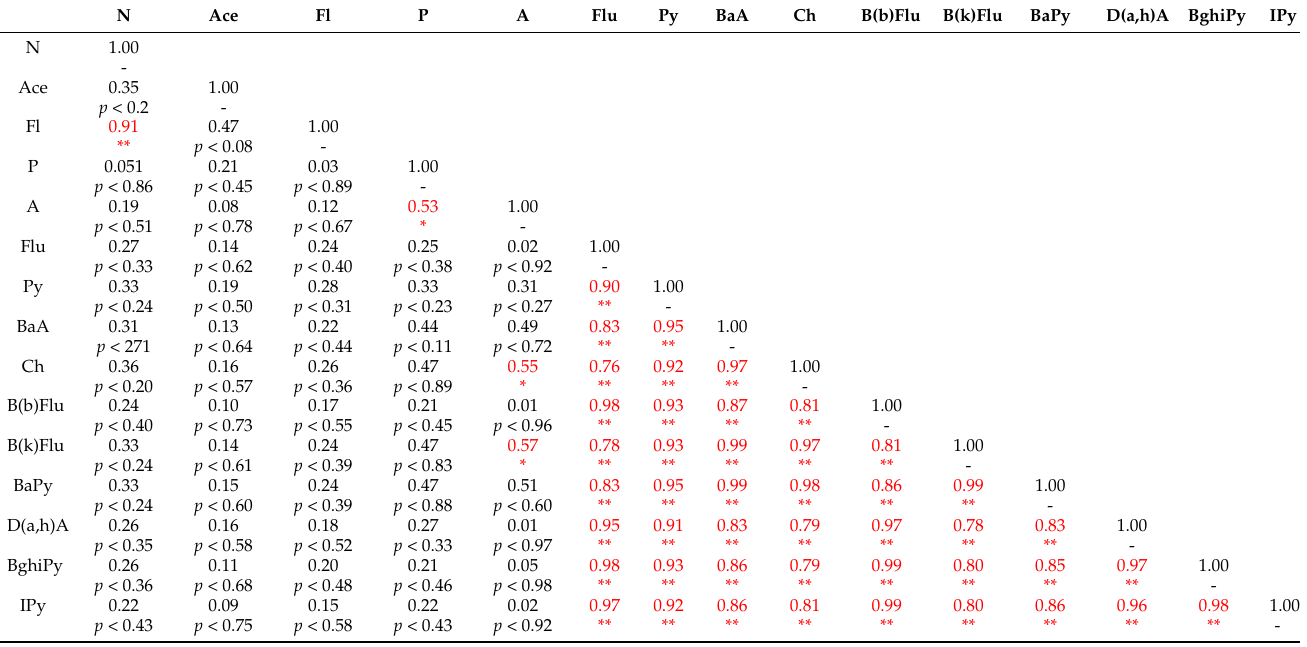
Table 4. Application of the Spearman correlation to contents of the PAHs in blood serum of smoker patients with